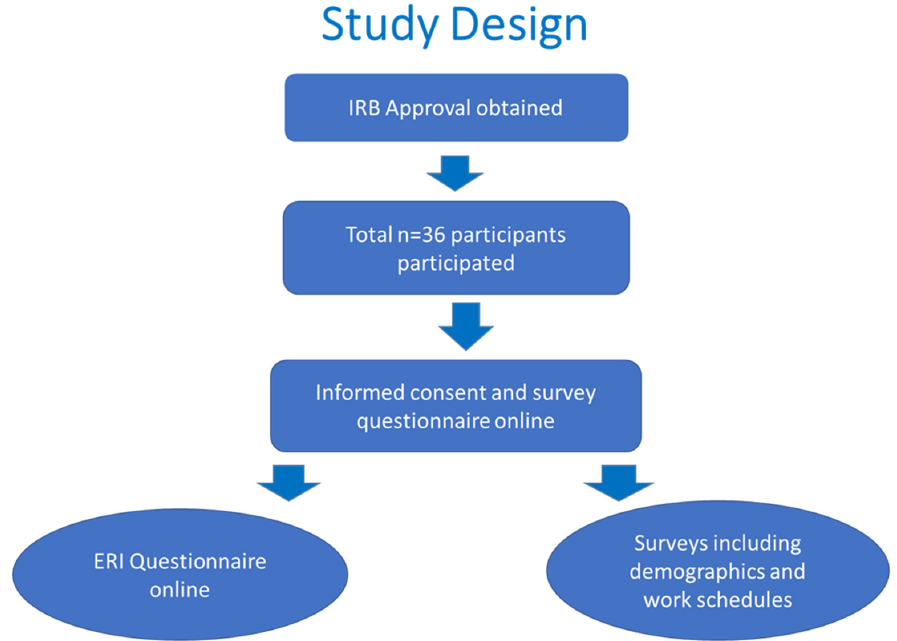
Figure 1. A fl ow diagram showing the study design. Figure 1. A flow diagram showing the study